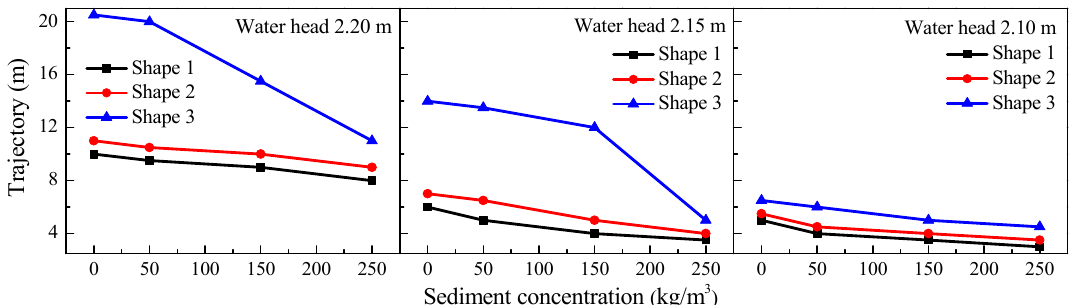
Water head 2.10 mWater head 2.15 m